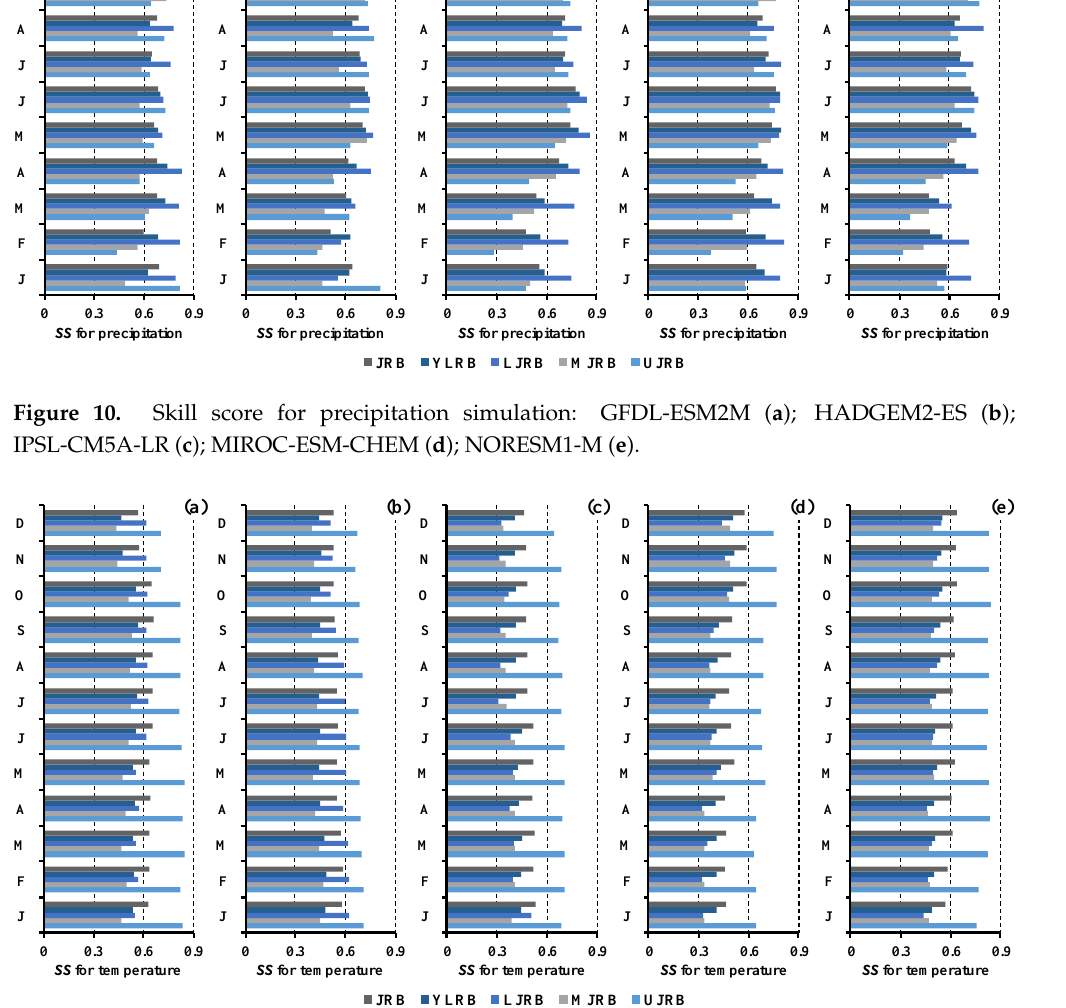
Figure 11. Skill score for temperature simulation: GFDL-ESM2M ( a ); HADGEM2-ES ( b ); IPSL-CM5A-LR ( c ); MIROC-ESM-CHEM ( d ); NORESM1-M ( e ).